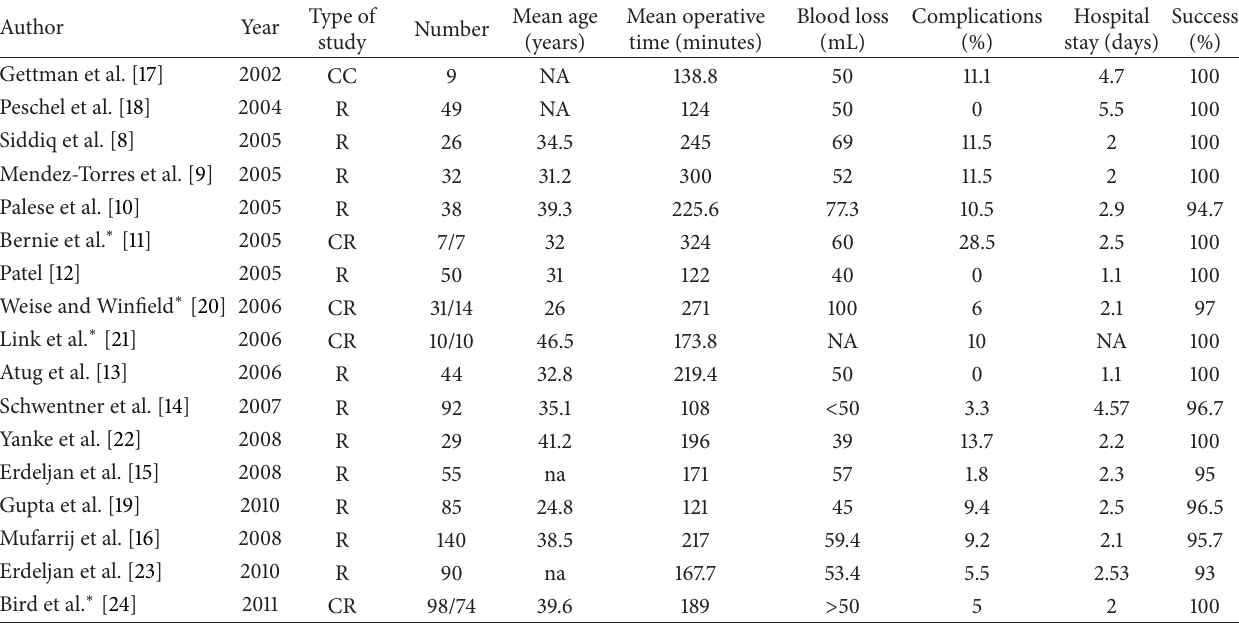
Table 3: Summary of case series on robotic